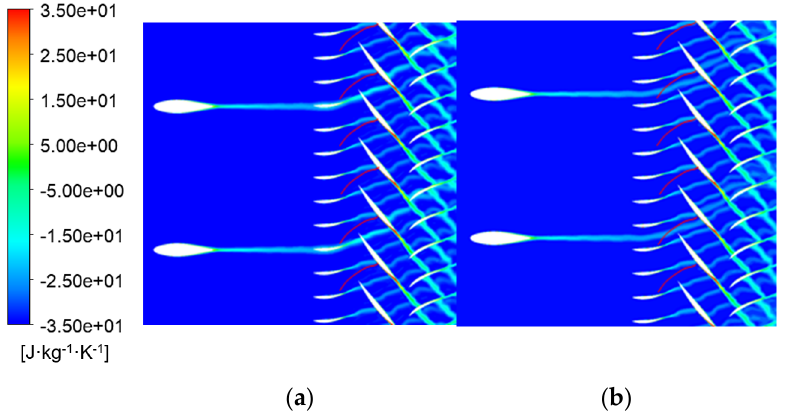
Figure 18. Static entropy at 50% blade span (red line is shock wave). ( a ) C# ( b ) M#.